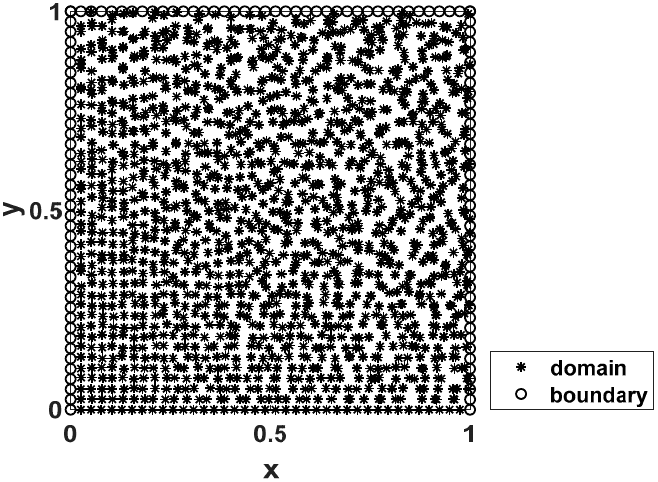
Figure 3. Non-uniform discretization using N s = N c = 40 ×